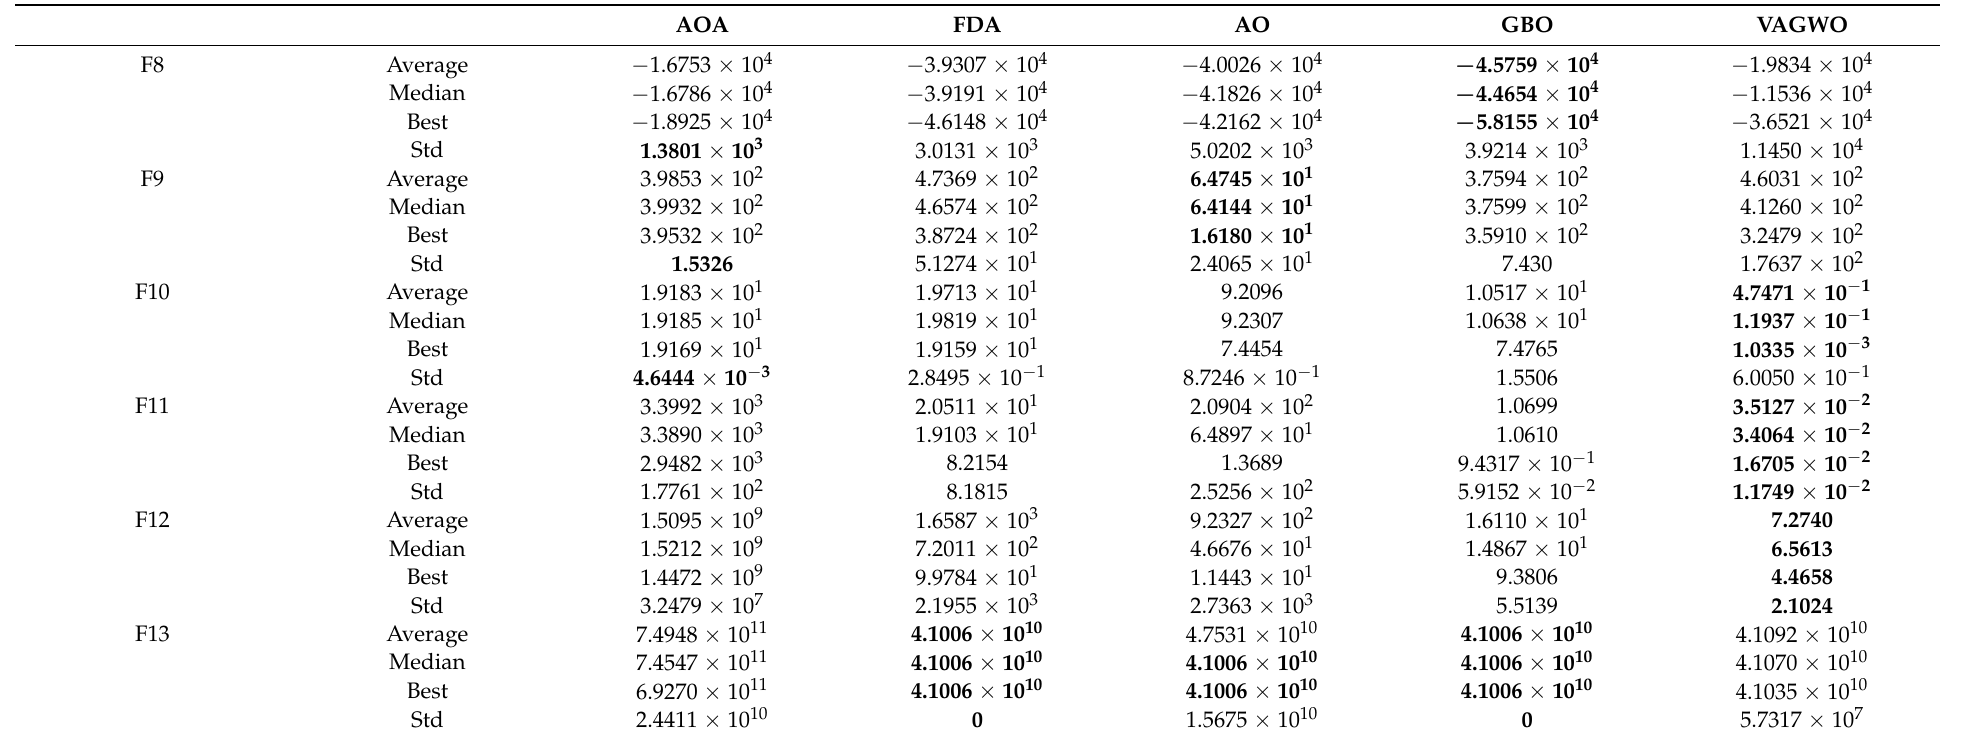
Table 7. The results achieved by the VAGWO and the newly proposed algorithms for the multi-modal functions at D =